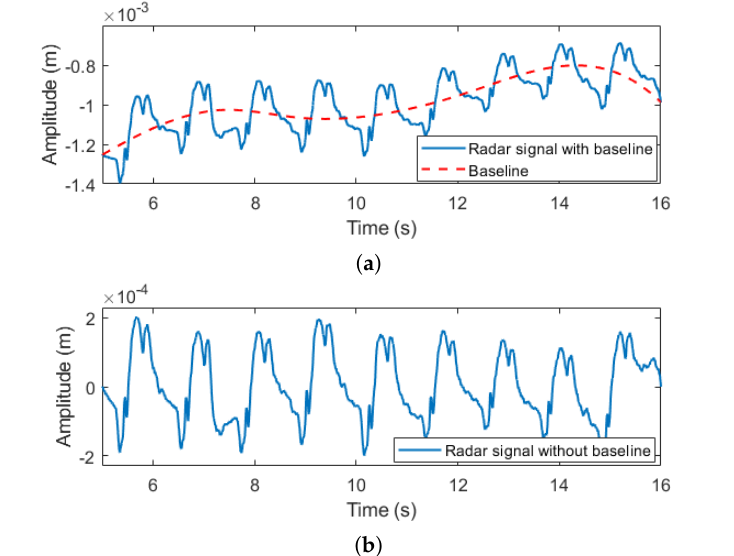
Figure 8. ( a ) Radar signal obtained for an apnea measurement and its baseline. ( b ) Radar signal after removing the baseline using the EMD